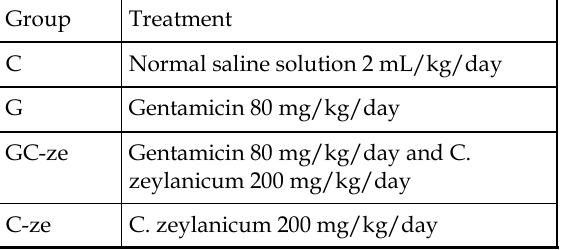
Table I: Different treatment groups of animals Group